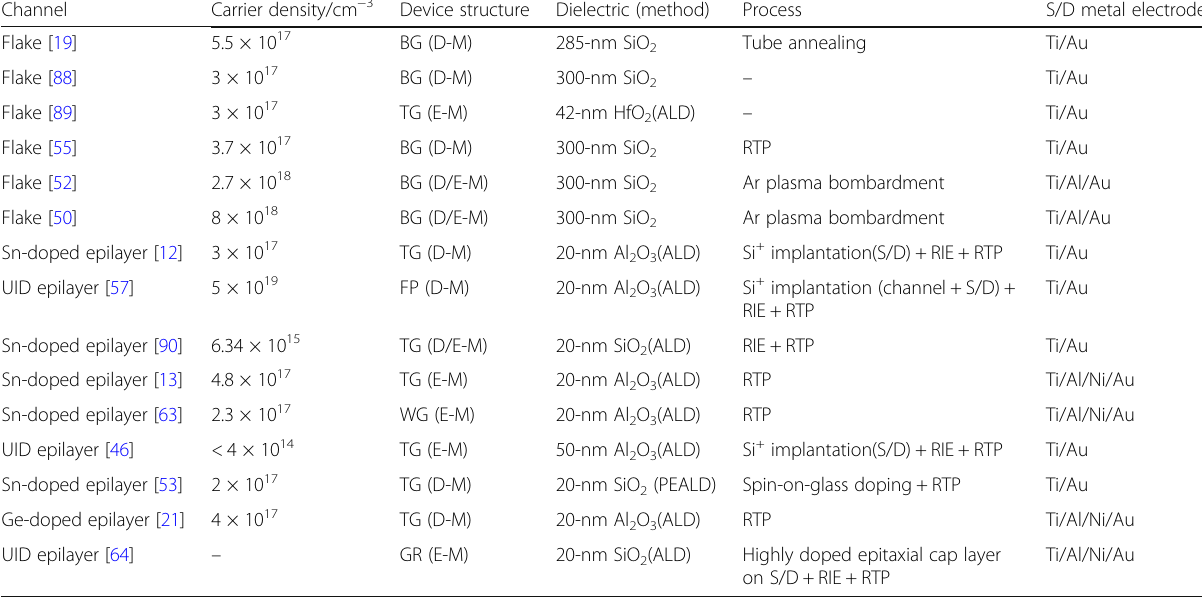
Table 1 The comparison of reported work about β -Ga 2 O 3 MOSFETs